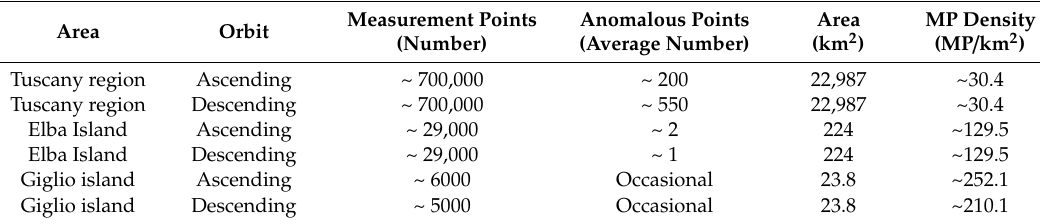
Table 4. MP and APs of ground deformation maps for each update of the monitoring system.